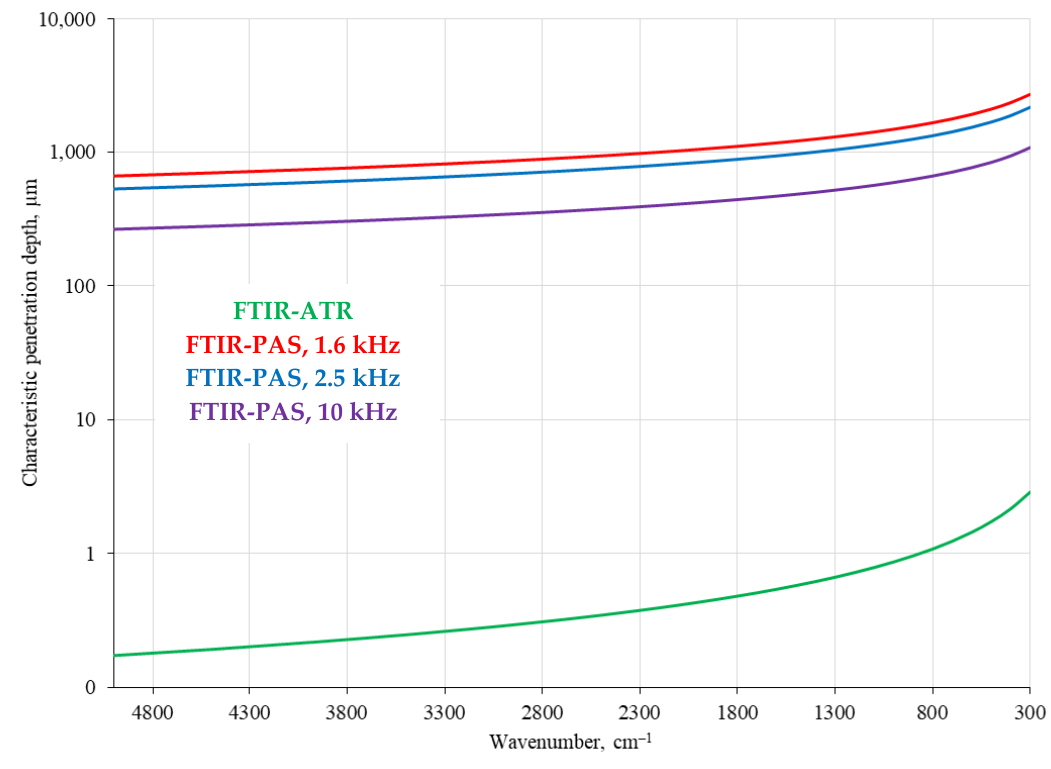
Figure A4. Radiation penetration depth into nanodiamond sample for ATR (green curve) and photoacoustic IR measurements at interferometer modulation frequencies 1.6 (red), 2.5 (blue) and 10 kHz (violet line).